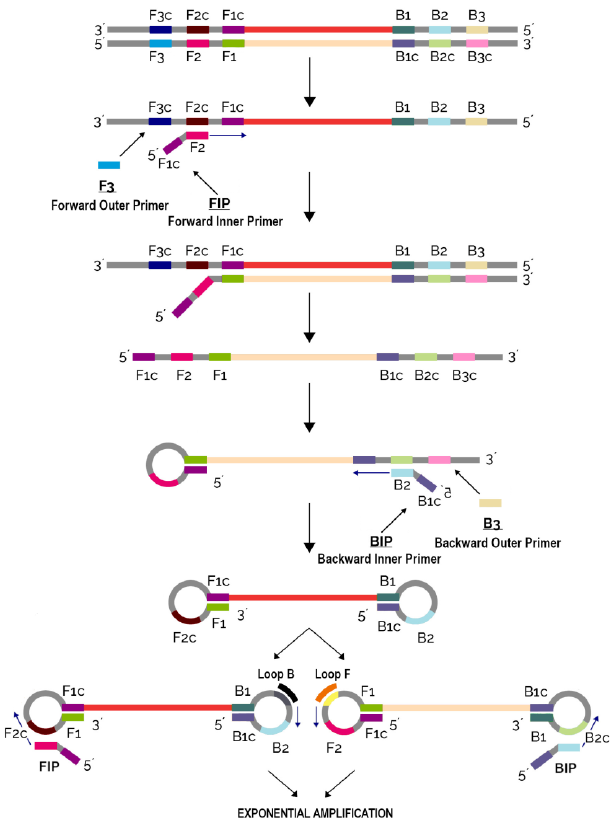
Figure 2. Nucleic acid amplification using loop-mediated isothermal amplification method (LAMP).